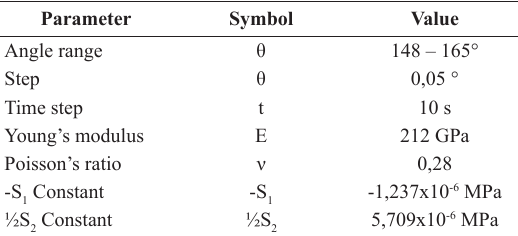
Table 1. Mechanical properties and parameters used to determine the residual stress values at each point with the sin 2 ψ from recorded diffractograms.